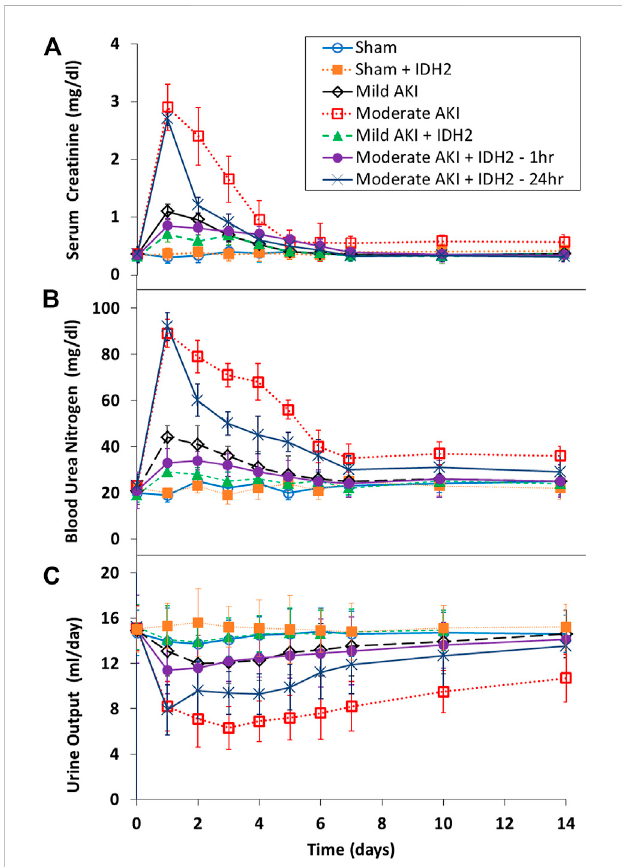
FIGURE 6 Blood biochemical and urine volumetric analyses. A comparative view of the restorative effects of upregulating IDH2 renal expression via hydrodynamic injections on (A) serum creatinine, (B) blood urea nitrogen, and (C) urine across the 14-day measurement period compared to characteristic injury responses. n = 3 for all